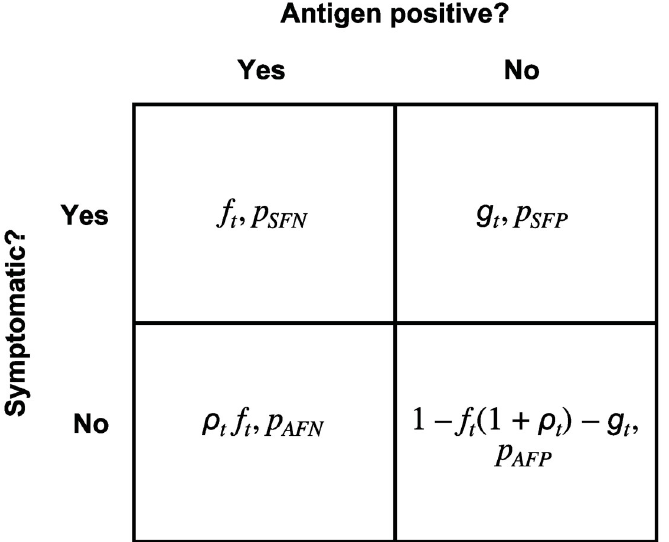
Fig 3. The population divided into four classes according to infection and symptom status. A fraction f t of the population is symptomatic and infected (antigen positive); such individuals have a probability of a false negative test p SFN . A fraction g t of the population is symptomatic but not infected; such individuals have a probability of a false positive test p . A fraction ρ of the population is infected but not symptomatic; such individuals have a probability SFP t f t of a false negative test p AFN . Finally, fraction 1 − f t − g t − ρ t f t = 1 − f t (1 + ρ t ) − g t of the population is neither infected nor . The subscript t indicates that these three symptomatic; such individuals have a probability of a false positive test p AFP parameters characterize the true state of the world, however none of them are observable.